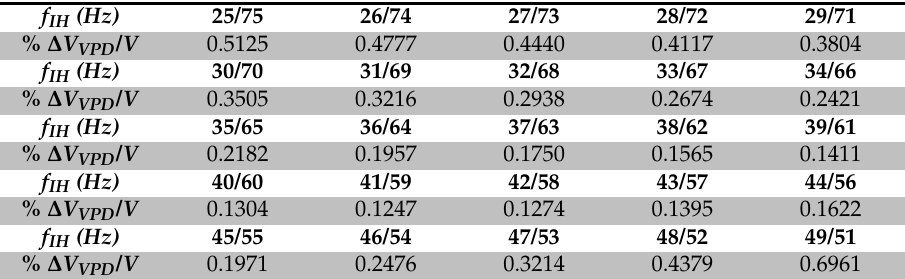
Table 1. The input relative ∆ V VPD / V values for each interharmonic frequency f IH .